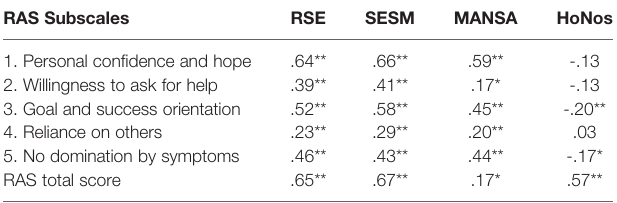
TABLE 3 | Convergent and divergent validity of RAS.